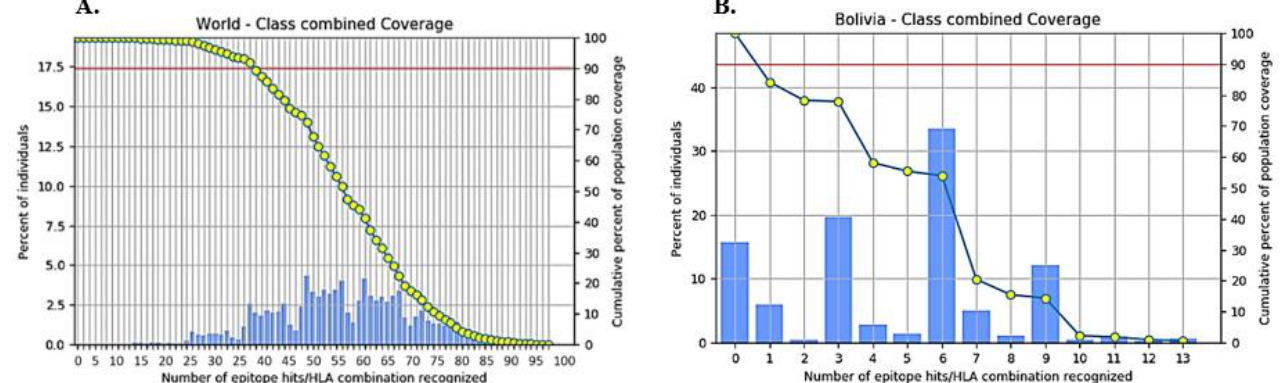
Figure 2. Population coverage of the potential epitopes and their target alleles. ( A ). World coverage; ( B ). Bolivian coverage. ( B ). Bolivian